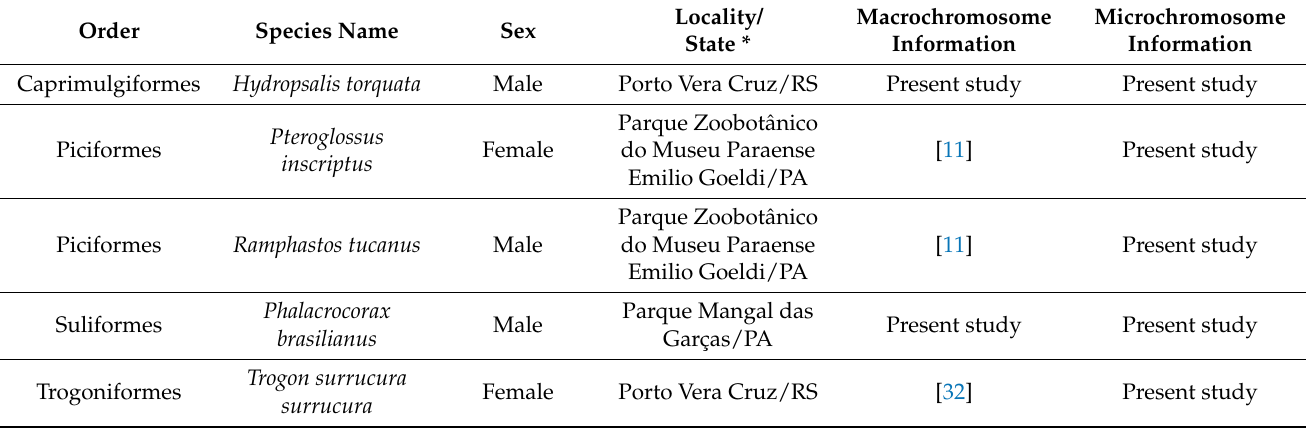
Table 1. List of the avian Neoaves species analyzed and the approaches